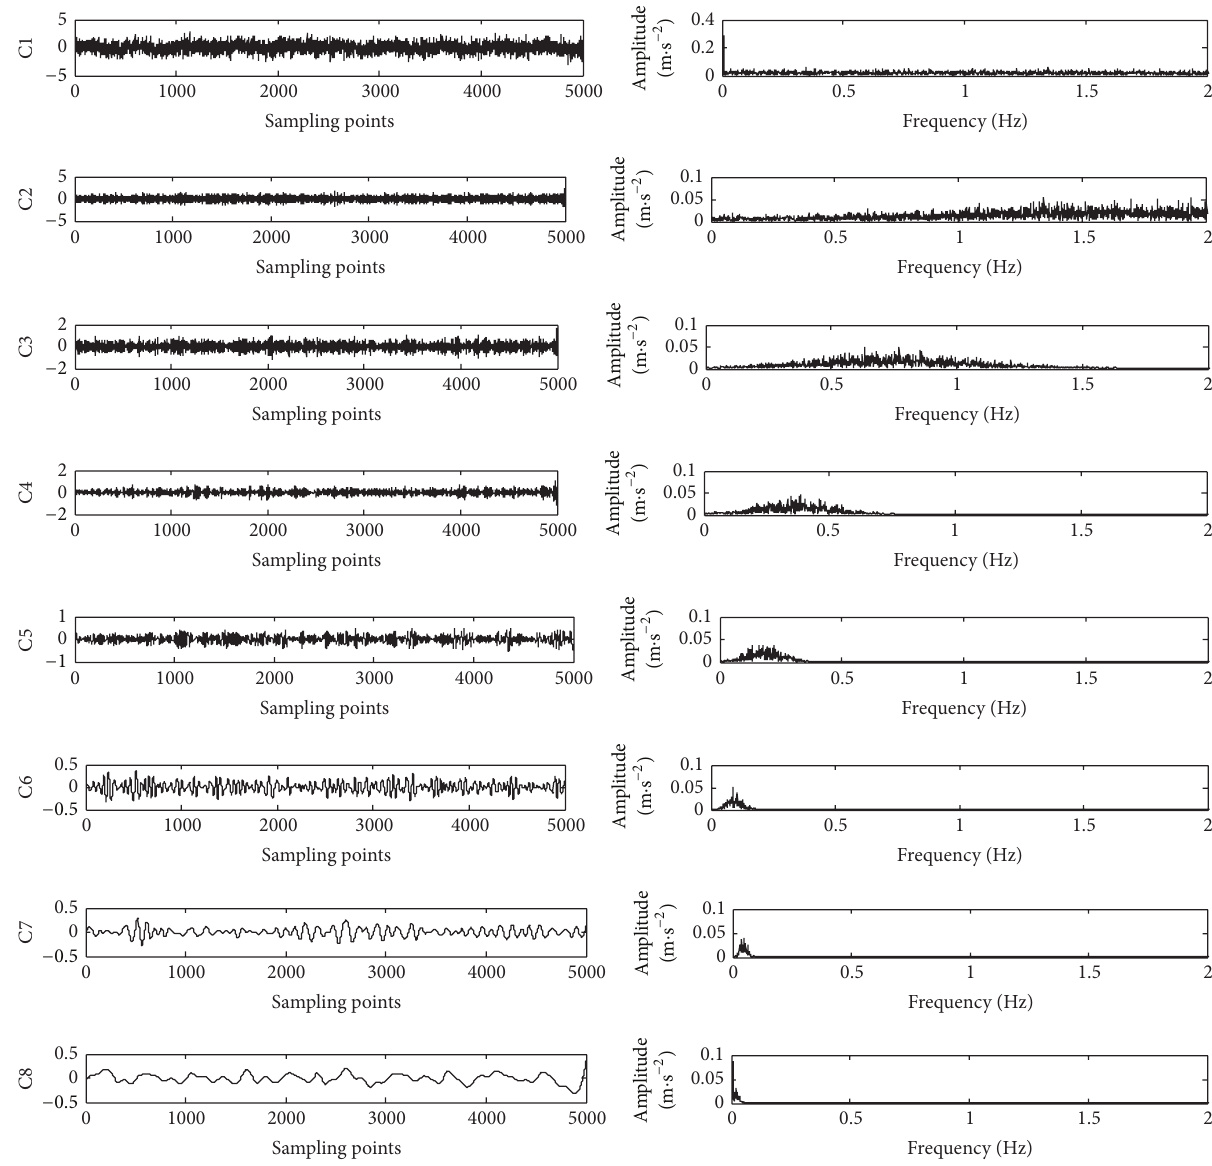
EEMD decomposition, which can make the signal whose frequency is 0.01 Hz